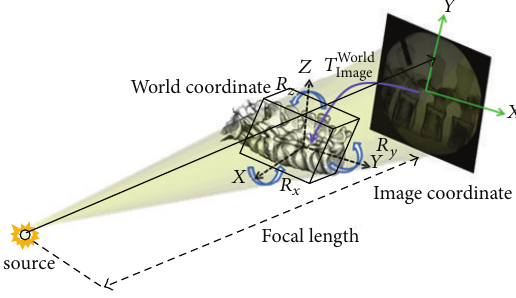
Figure 6: The ray-tracing projection model of DRR